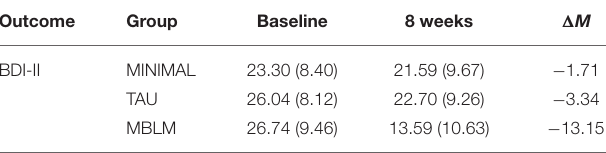
TABLE 4 | Changes in BDI-II scores from clinical